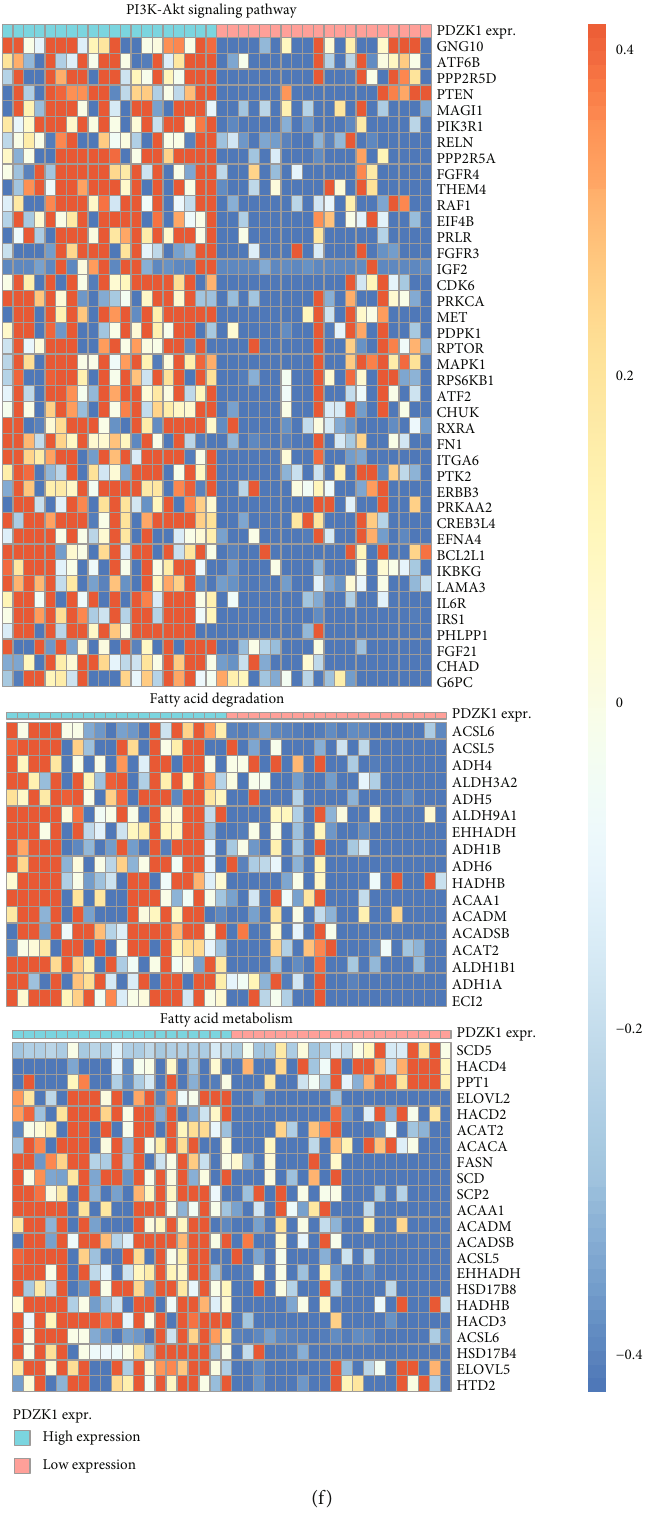
Figure 3: PDZK1 has oncogenic roles by enhancing PI3K/AKT and fatty acid metabolism. (a) Heat map of all DEGs obtained by comparing PDZK1 top 20 high and top 20 low samples. (b) GO enrichment for biological process (BP) based on the DEGs. (c) KEGG enrichment based on the DEGs. (d) GSEA analysis for gene expression fold change between PDZK1 top 20 high and top 20 low samples. (e) GSEA plot for PI3K-AKT, fatty acid metabolism, and fatty acid degradation pathways. (f) Heat map for key genes representing PI3K-AKT, fatty acid metabolism, and fatty acid degradation